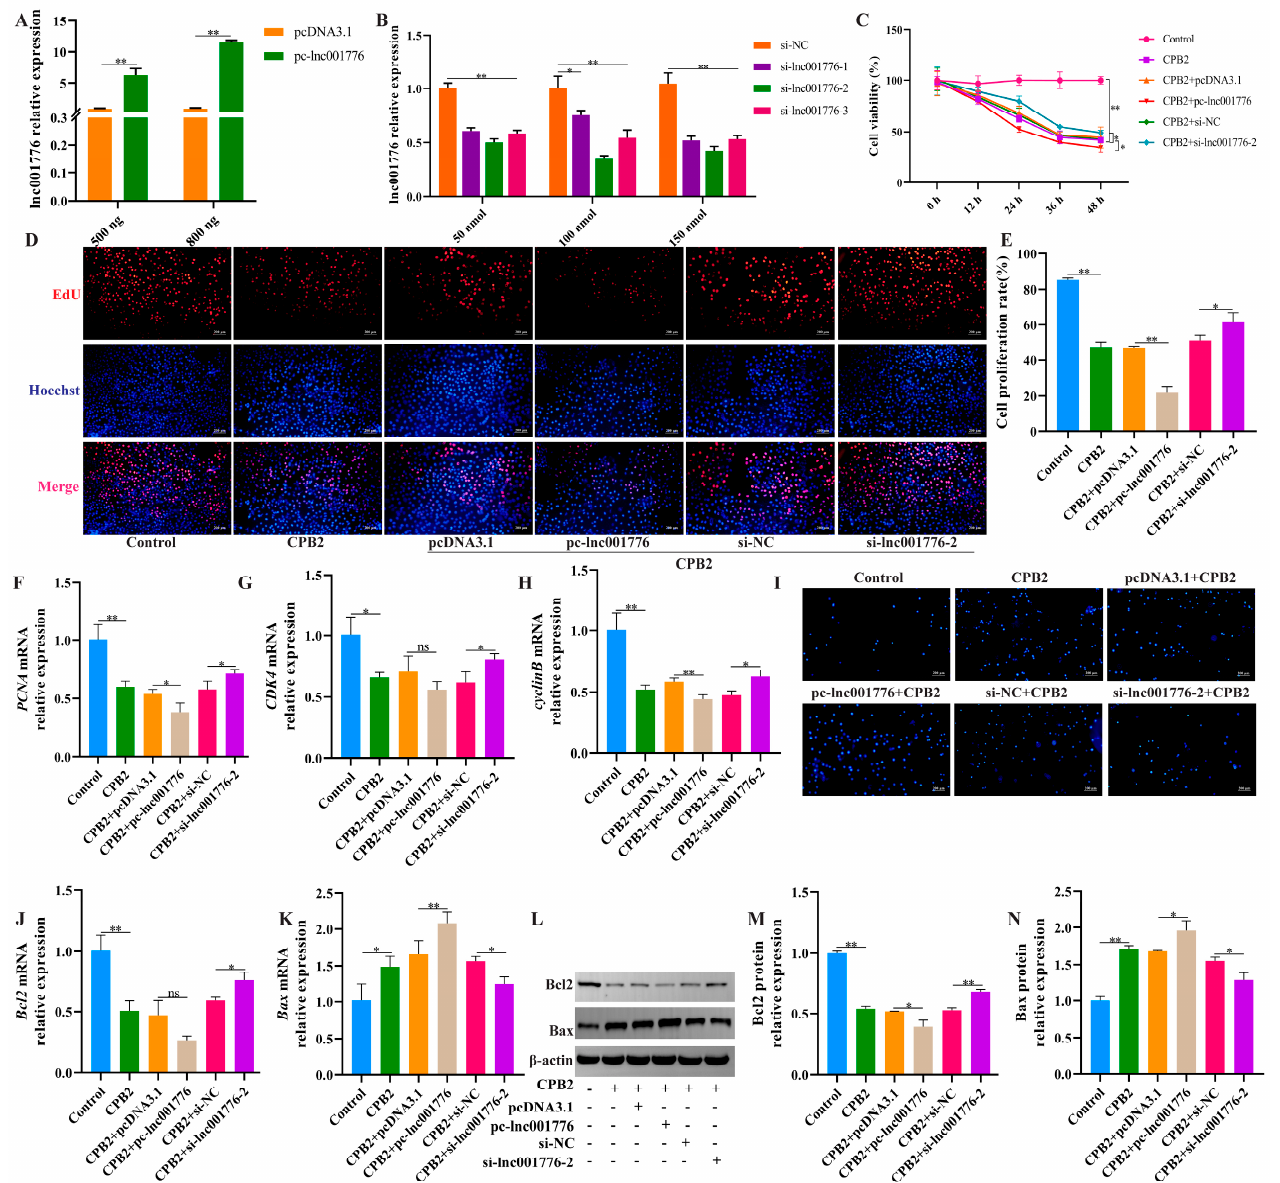
Figure 2. lnc001776 knockdown alleviated CPB2 toxin-triggered apoptosis in IPEC-J2 cells. ( A ) lnc001776 overexpression efficiency via RT-qPCR. ( B ) lnc001776 knockdown efficiency via RT- qPCR. ( C ) Cell viability through CCK-8. ( D ) Cell proliferating by EdU staining. ( E ) Percentage of red positive proliferating cells. ( F – H ) PCNA , CDK4 and cyclinB levels through RT-qPCR. ( I ) Cell apoptosis by Hoechst 33258 staining. ( J , K ) Bcl2 and Bax mRNA expression via RT-qPCR. ( L – N ) Bcl2 and Bax protein expression through Western blot. ns: not signi fi cant. * p < 0.05, ** p < 0.01.